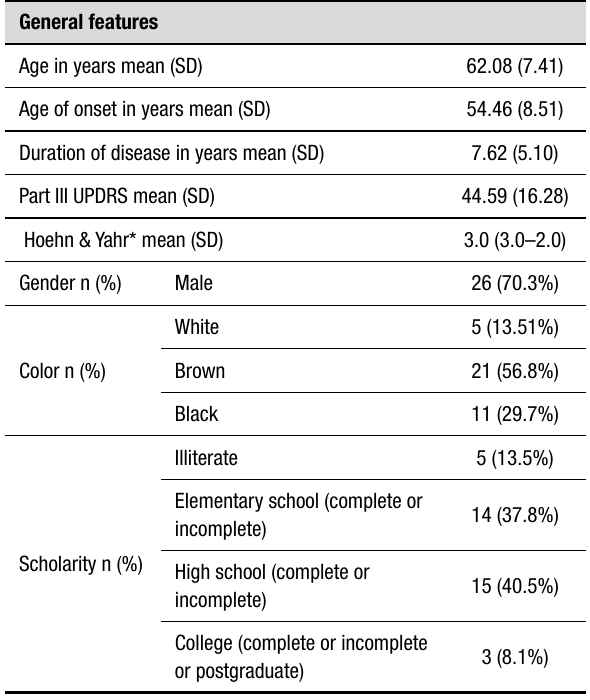
Table 1. Demographic and clinical characteristics of the sample. General